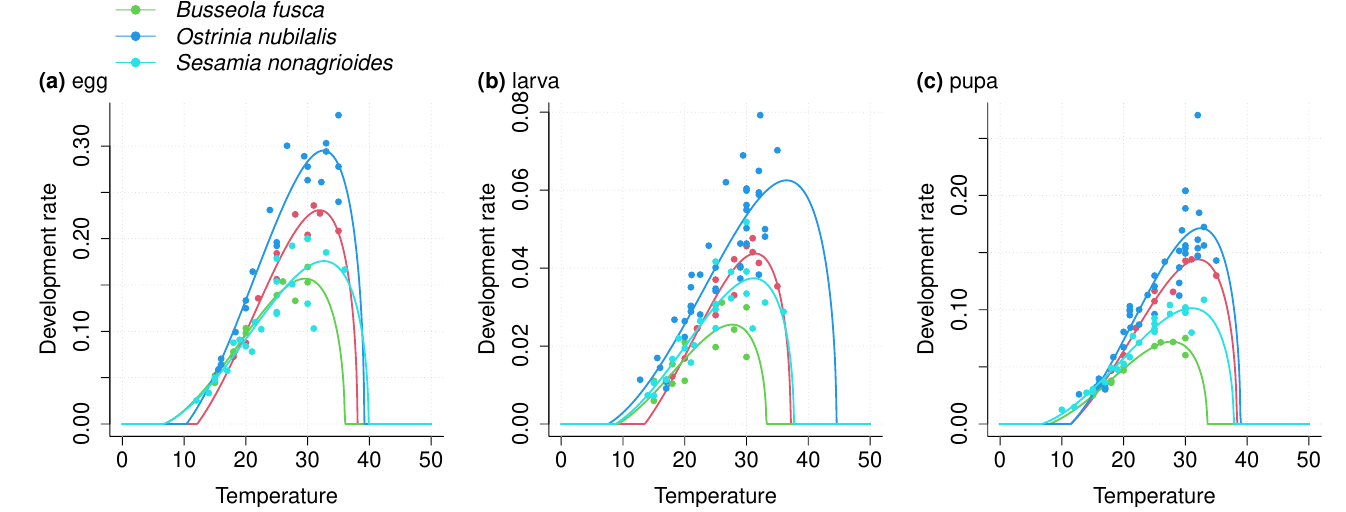
Figure 3. Thermal performance curves for ( a ) egg, ( b ) larva and ( c ) pupa life stages of Chilo partellus , Busseola fusca , Ostrinia nubilalis , and Sesamia nonagrioides . Development rate as a function of tempera- ture is shown. Development rate is defined as the inverse of development time and quantifies the fraction of development time accomplished per day at a given temperature. For each species and each life stage, we extracted mean development times measured at different constant temperatures from other studies (see Table 1). We computed the inverse and pooled the extracted data from different studies for each species and each life stage. Then, eleven non-linear models were fitted to the pooled experimental data using the non-linear least squares method, and one model was selected based on statistical and biological criteria, for each species and each life stage.